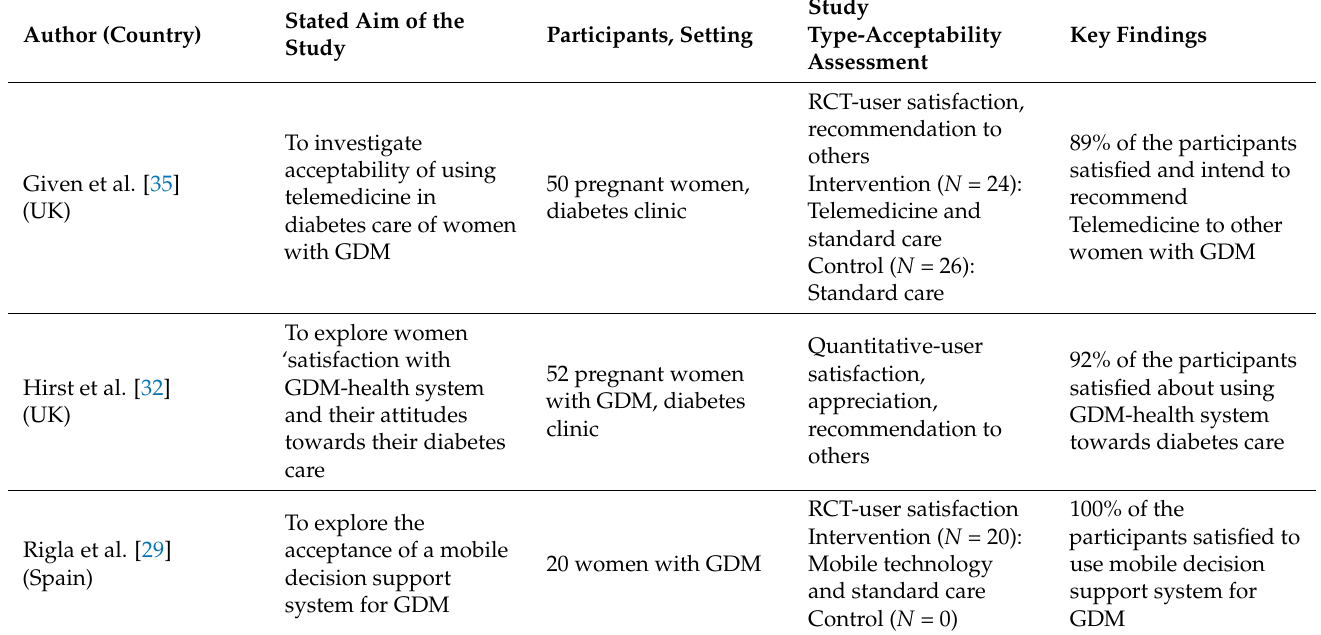
Table 4. Overview of studies reporting on the acceptability of digital tools to support dietary self- management of gestational diabetes